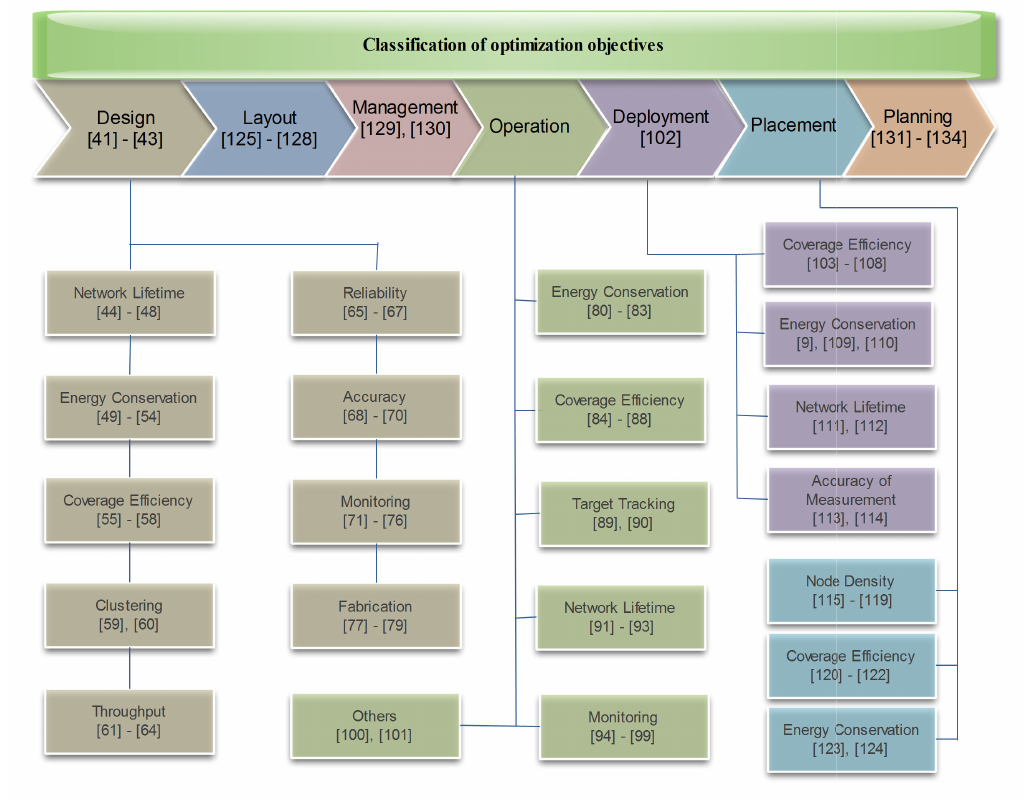
Figure 2. Classification of optimization